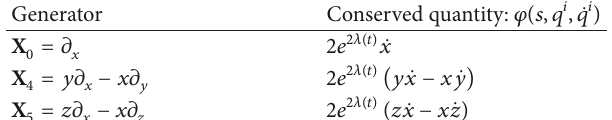
Table 34: Conserved quantities corresponding to each Noether